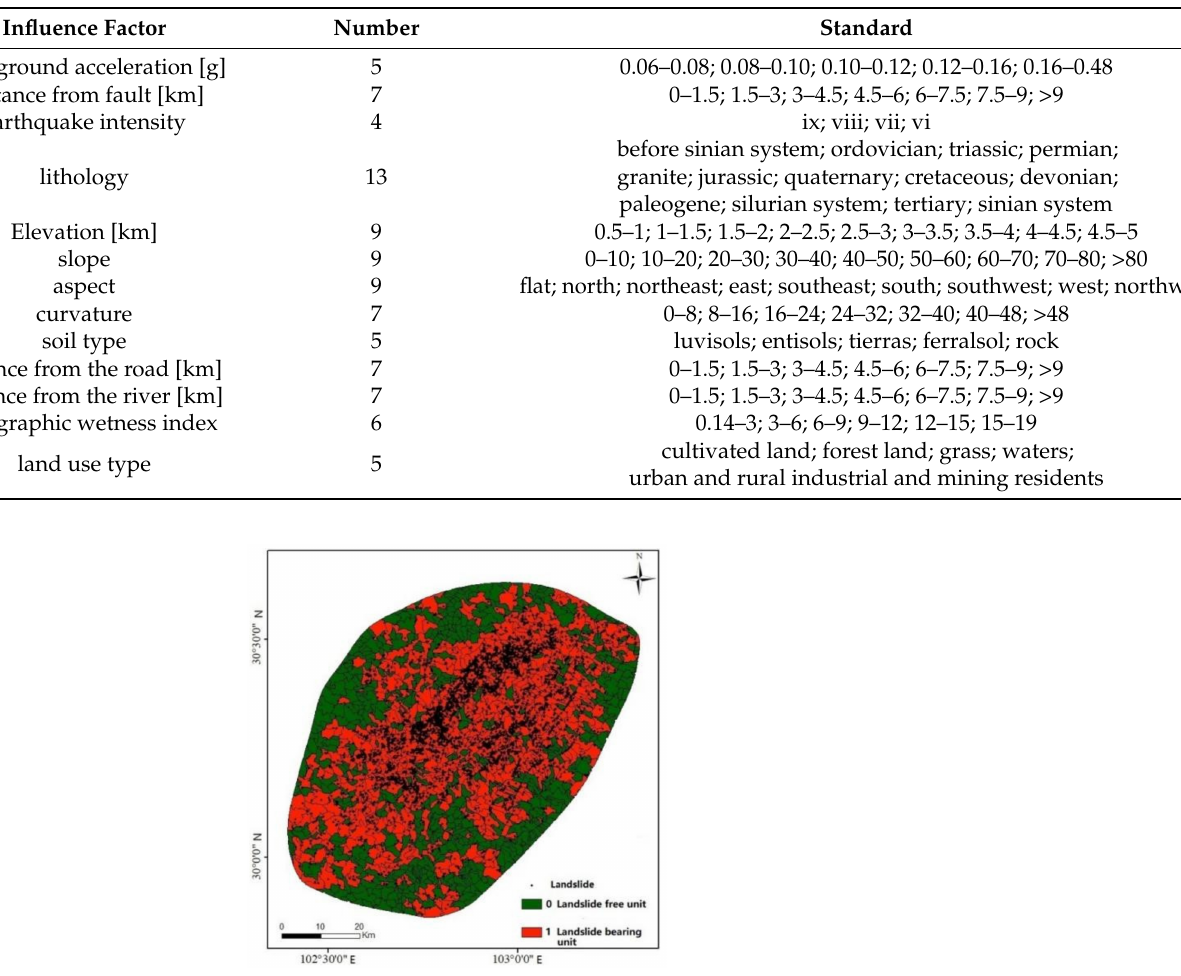
Figure 4. The distribution of landslide free unit and landslide bearing